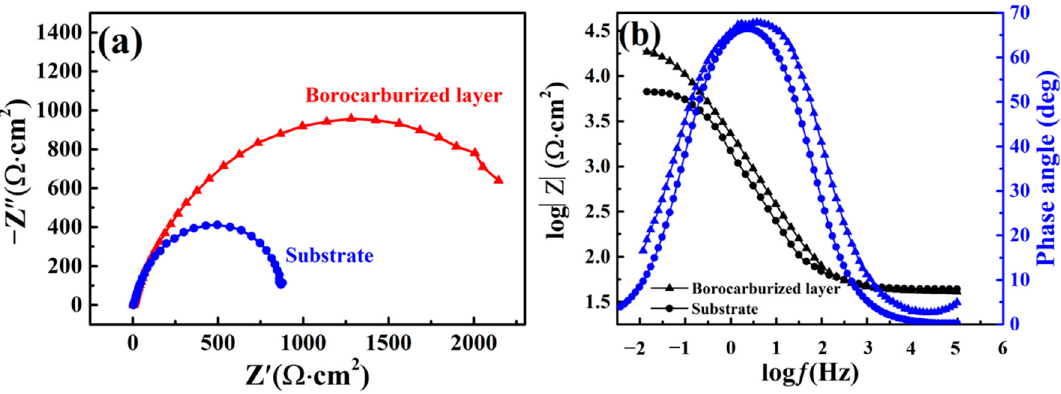
Figure 9. Electrochemical impedance spectroscopy plots of borocarburized layer and substrate ( a ) Nyquist plots, ( b ) Bode plots.